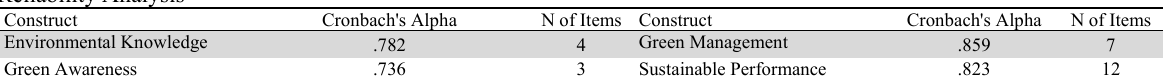
Reliability Analysis